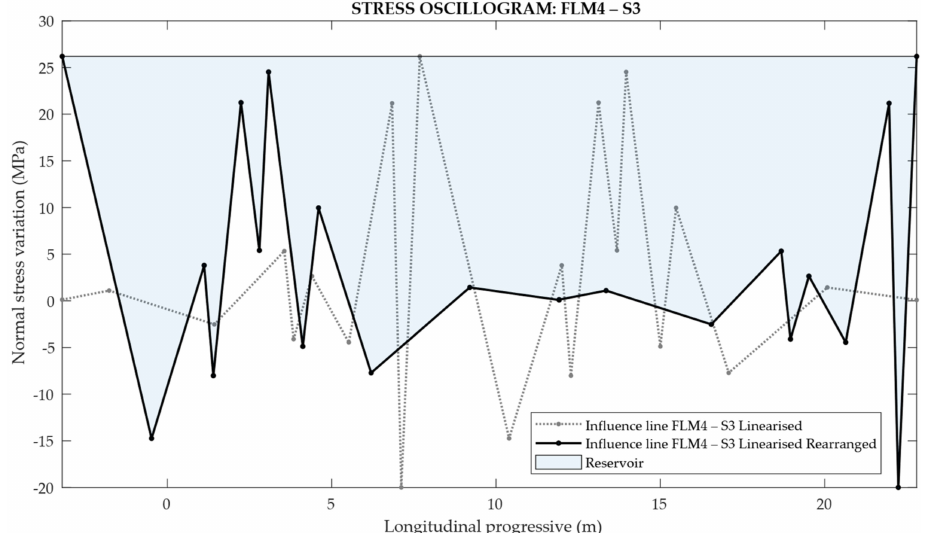
Figure 27. Reservoir method for the transit of the lorry silhouette 3 for the